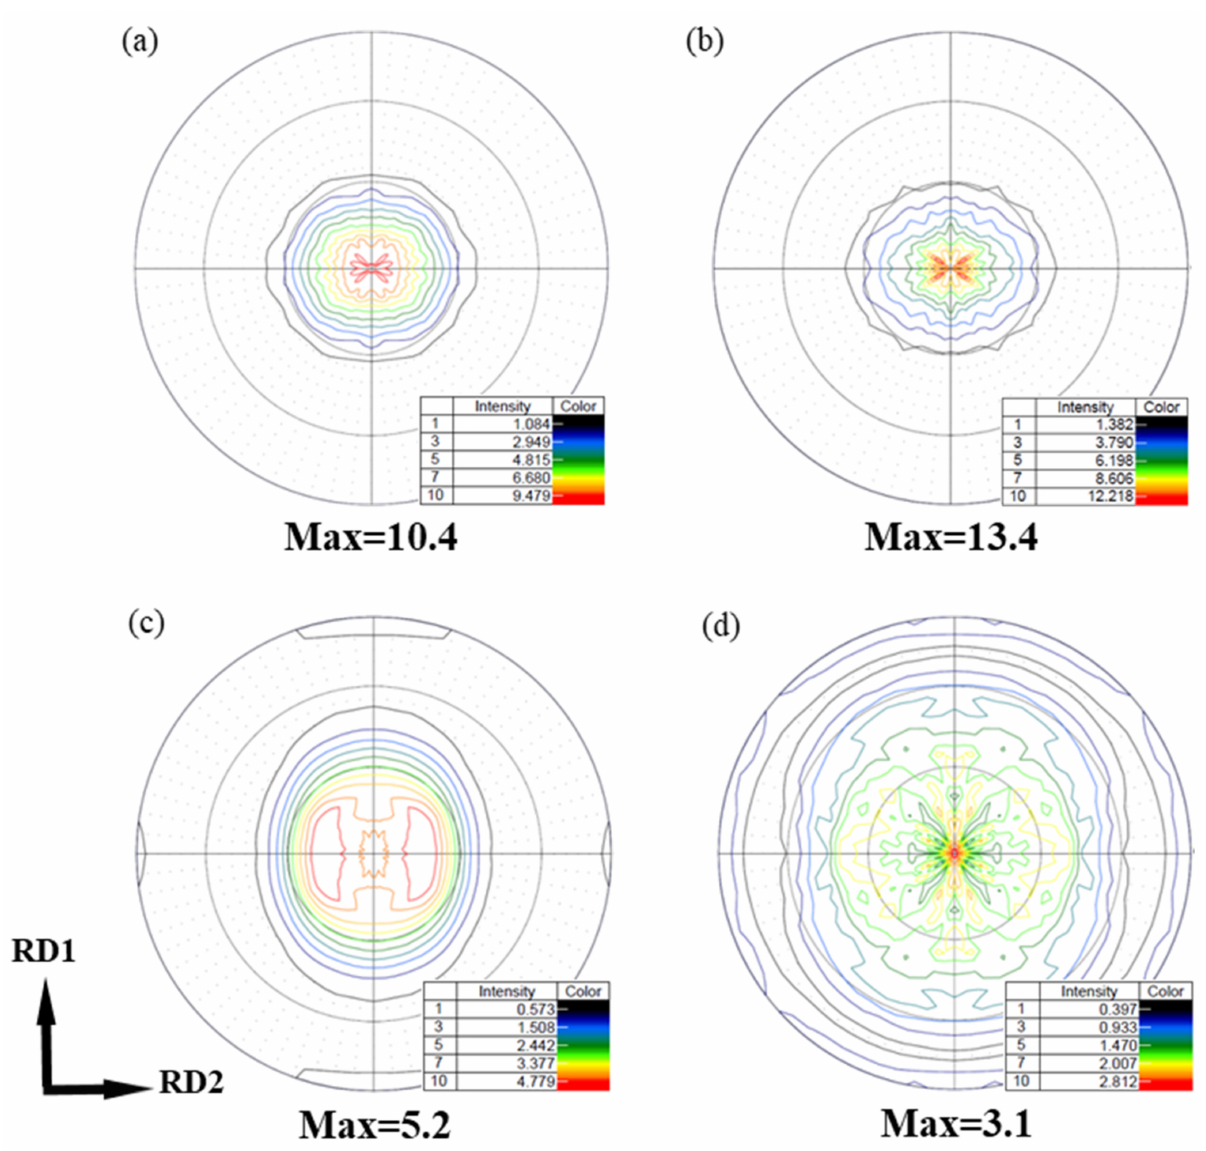
Figure 20. X-ray recalculated (0002) pole figure of ( a ) as-rolled and ( b ) as-annealed pure Mg sheets; ( c ) as-rolled and ( d ) as-annealed Mg-3Y